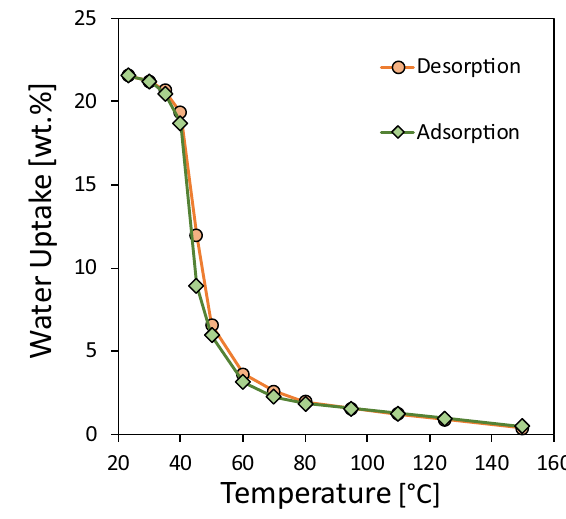
Fig. 6 Water adsorption/desorption isobars at 11 mbar for ZF-70 foam